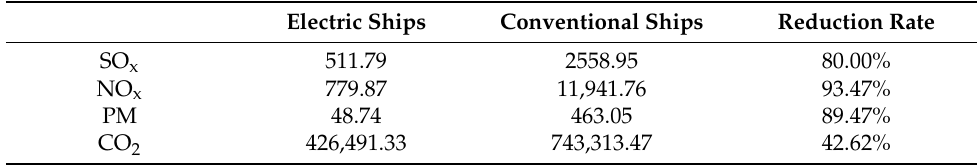
Table 8. The emission of electric and conventional ships (thousand